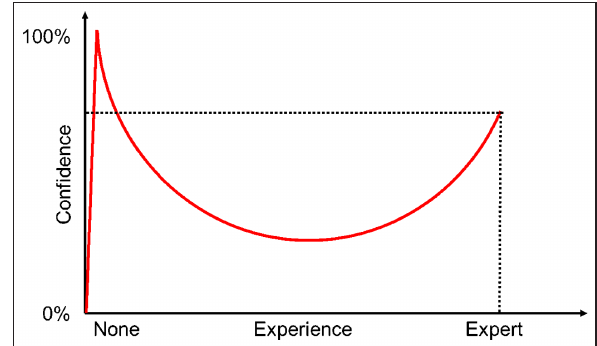
Figure 7: The Dunning-Kruger Effect (illustrative sim- plified version). “Those with limited knowledge in a domain suffer a dual burden: Not only do they reach mistaken conclusions and make regrettable errors, but their incompetence robs them of the ability to realize it” (Kruger and Dunning